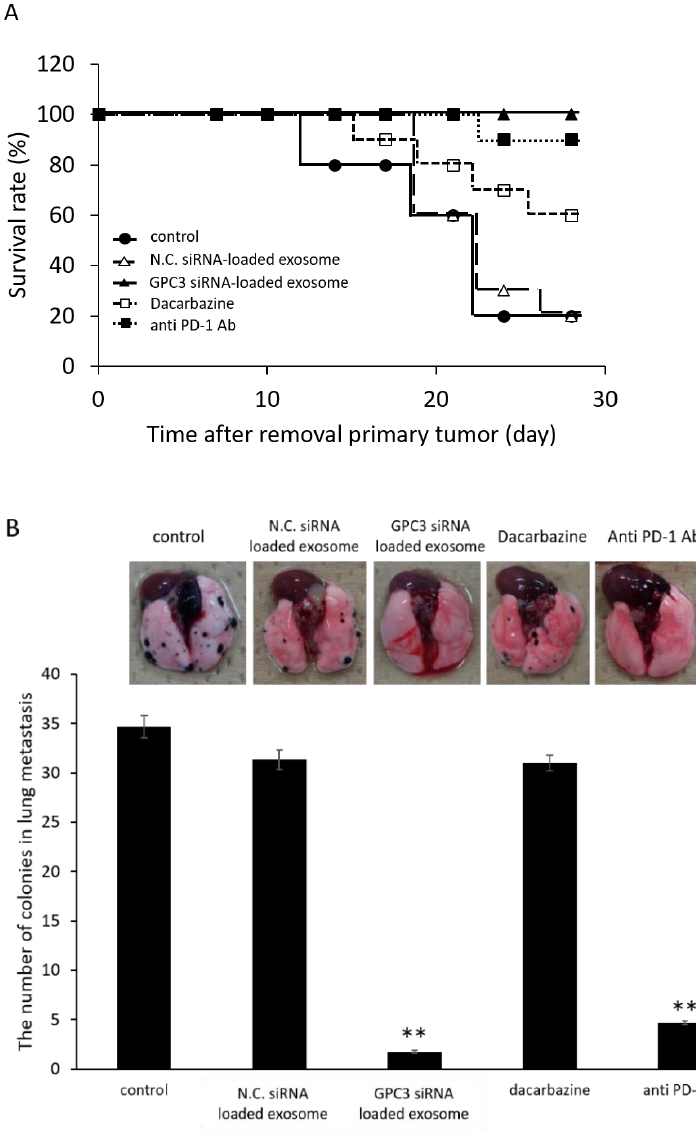
Figure 8. Survival rate ( A ) and anti-metastatic effects ( B ) in the lung metastasis of B16/BL6 sponta- neous lung metastasis model mice treated with siRNA-loaded autologous exosome prepared with isolated from serum collected at days 14 after transplantation of B16/BL6 cells. Data represent the mean ± SD of five independent experiments; ** p < 0.01 versus control B16/BL6 spontaneous lung metastasis model mice (Bonferroni test/ANOVA).